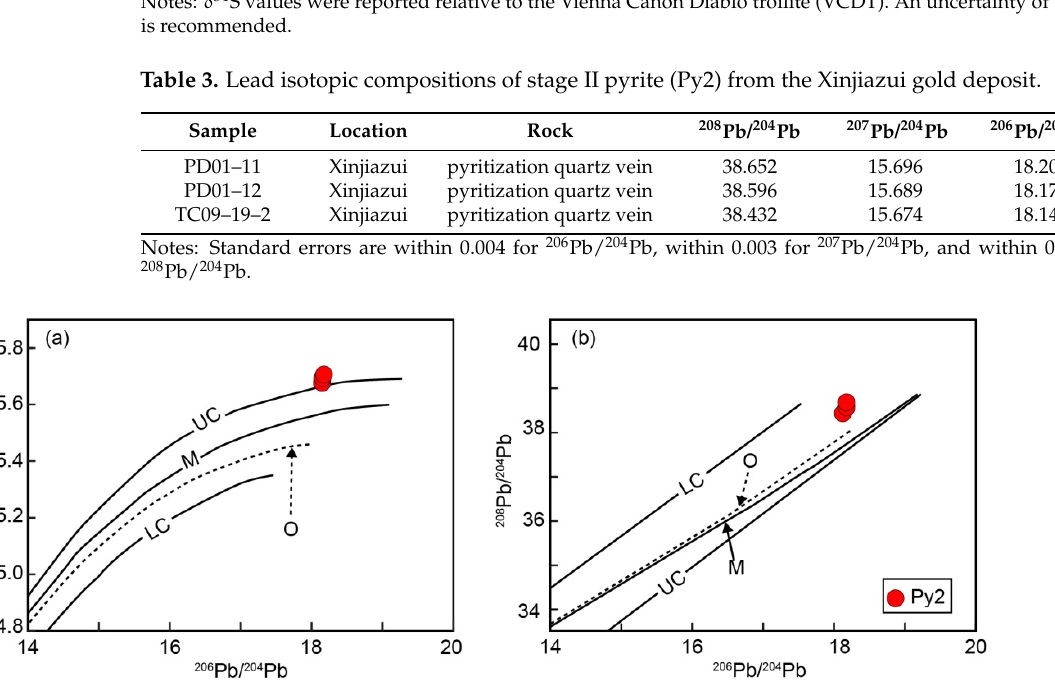
Figure 6. Pb isotopic composition of samples from the Xinjiazui gold deposit plotted with the evolution curve of Zartman and Doe (1981) [49], including ( a ) 208 Pb/ 204 Pb vs. 206 Pb/ 204 Pb and ( b ) 207 Pb/ 204 Pb vs. 206 Pb/ 204 Pb. LC: lower crust; M: mantle; O: orogen; UC: upper crust.